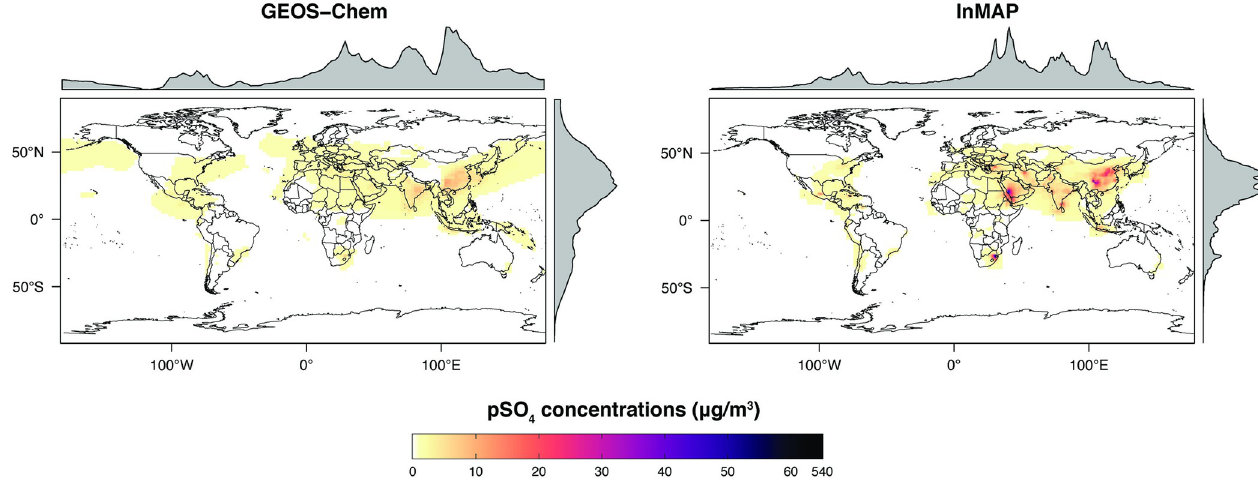
Fig 3. Global InMAP and GEOS-Chem annual-average ground-level pSO 4 concentrations.